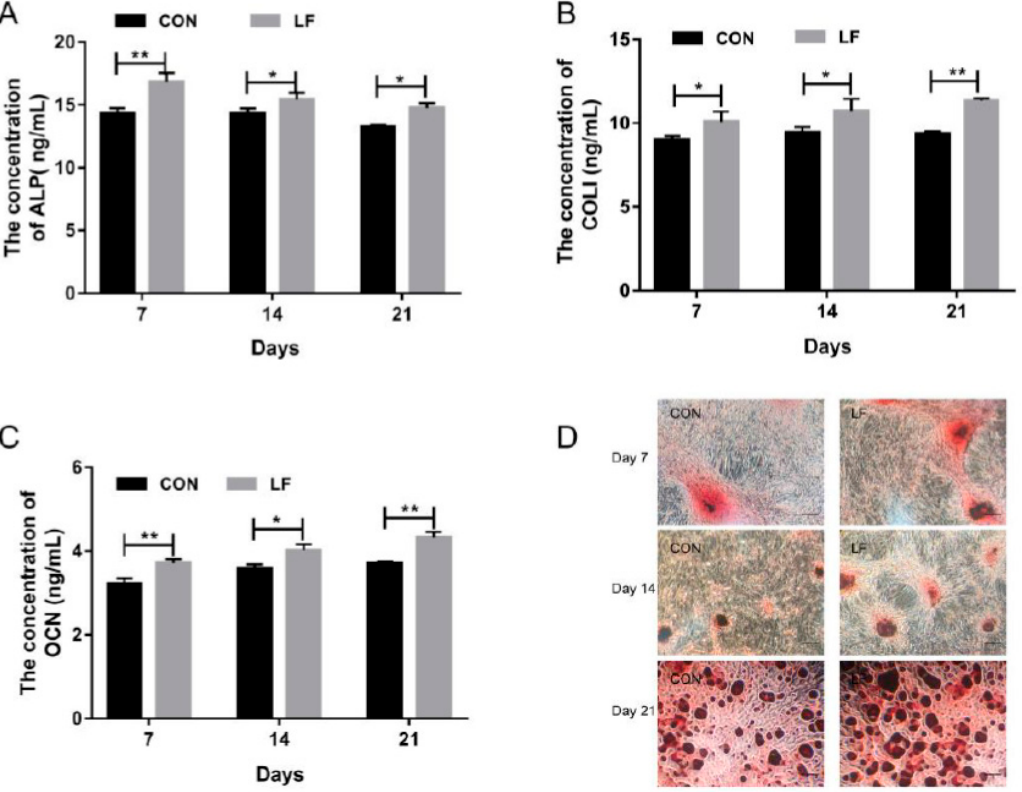
Figure 1. The osteogenic differentiation capacity of control rBMSCs (CON group) and Lactoferrin (LF)-treated rBMSCs (LF group). ( A ) Alkaline phosphatase (ALP) activity of rBMSCs on day 7, 14 and 21; ( B ) COLI expression of rBMSCs on day 7, 14 and 21; ( C ) Osteocalcin (OCN) expression of